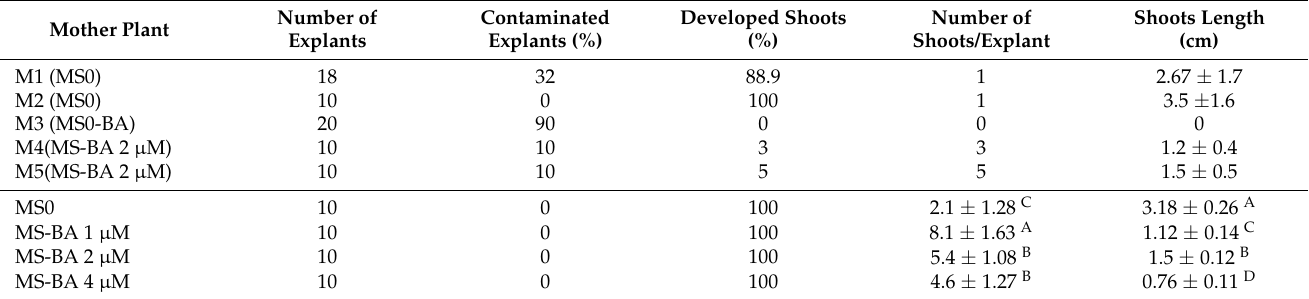
Table 1. In vitro culture of A. caerulescens . Single mother plants (M) were used as initial explants, and their contamination was observed (%). Effect of different culture media on shoot development (%). Proliferation and length of shoots (cm) after 4 weeks of cultivation. Data are presented as means ± SD ( n =